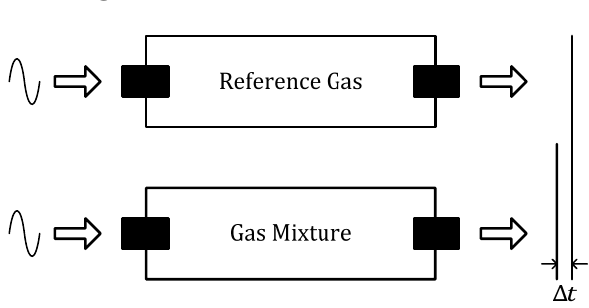
Figure 6. Method of ultrasonic